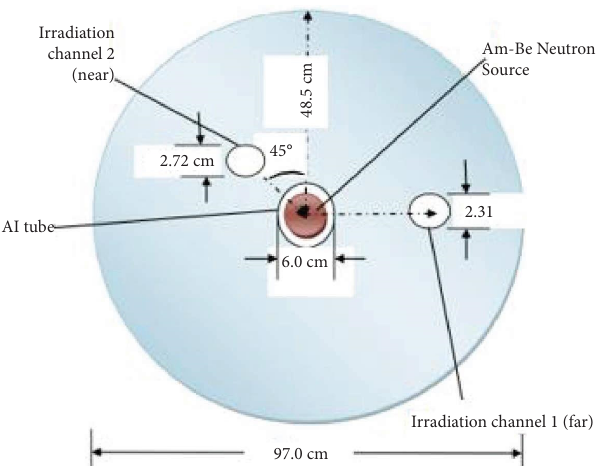
Figure 2: Schematic cross-sectional view of 241 Am-Be neutron source